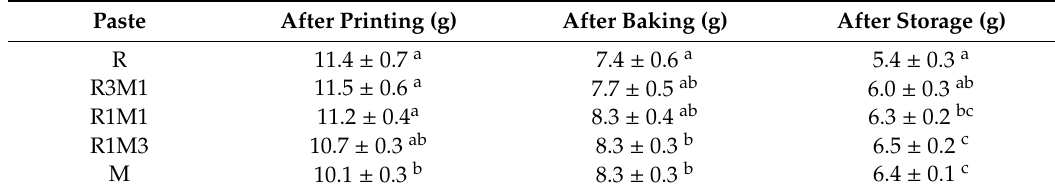
Table 5. Weights of 5-layer samples after printing, baking and storage ( n = 6). Di ff erent letters within the same column indicate significant di ff erence ( p < 0.05). Paste